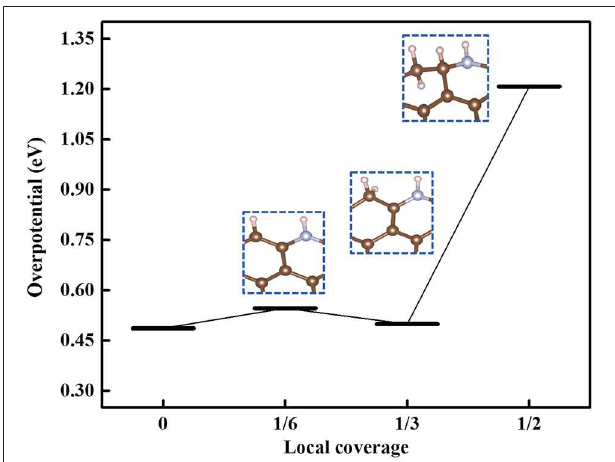
FIGURE 5 | The overpotential of ORR at different local coverage rate. The models in the blue dotted frame are the best adsorption configuration under this local coverage.